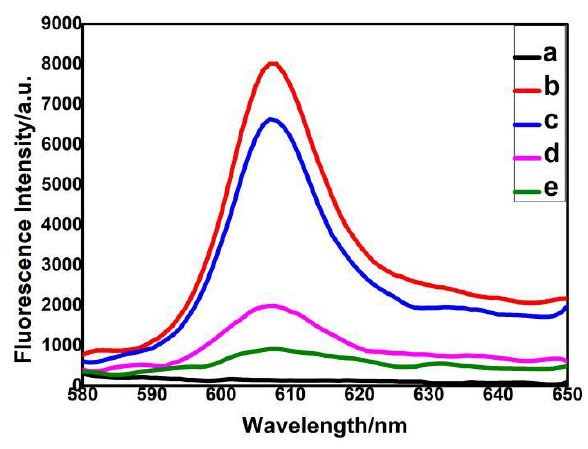
Figure 1. Fluorescence-emission spectra of the di ff erent samples: ( a ) S; ( b ) S + NMM; ( c ) S + Thrombin + GO + NMM; ( d ) S + GO + NMM; ( e ) NMM. The concentrations of S, thrombin, GO, and NMM are 0.25 µ M, 0.2 µ M, 30 µ g · mL − 1 , and 1.5 µ M,